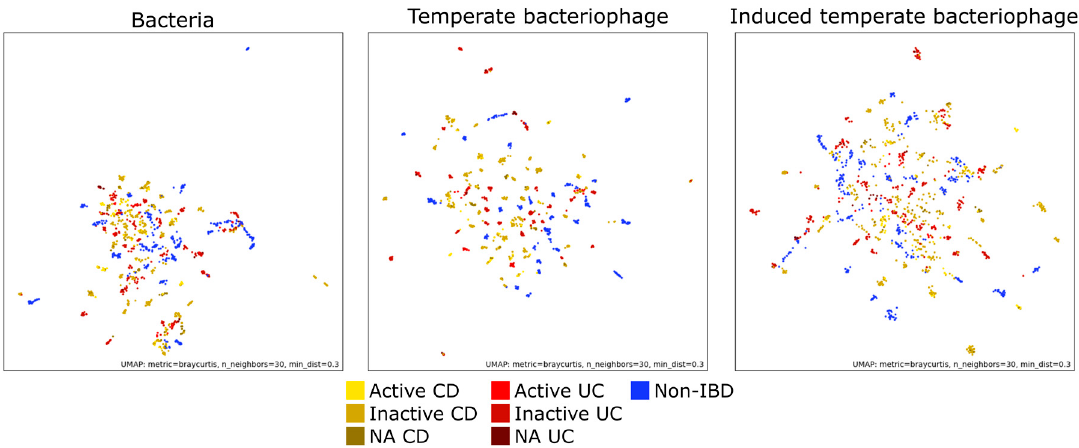
Figure 4. Ordination of gut microbial communities. Dissimilarity among gut microbial communities was assessed using the Bray–Curtis dissimilarity measure and ordinated in two dimensions using uniform manifold approximation and projection for dimension reduction (UMAP). The following samples were used: 87 active Crohn’s disease (CD) samples from 24 patients, 448 inactive CD samples from 48 patients, 45 NA CD samples from 17 patients, 29 active ulcerative colitis (UC) samples from 9 patients, 298 inactive UC samples from 29 patients, 21 NA UC samples from 7 patients, and 362 non-IBD samples from 26 patients. NA CD and NA UC samples refers to those lacking Harvey–Bradshaw index (HBI) and simple clinical colitis activity index (SCCAI) scores, respectively.